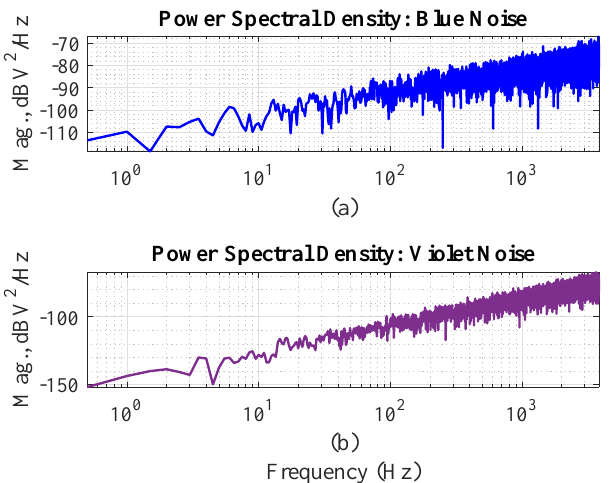
Figure 6. Power spectral density with of the additive ( a ) blue noise and ( b ) violet noise of SNR = 5 dB. Tables 2 and 3 respectively indicate the mean of the estimated parameters and the percentage error for the signal s 1 ( t ) in 1000 runs at each signal-to-noise ratio (SNR) of 5, 20, 30, and 40 dB considering s 1 ( t ) contaminated by pink